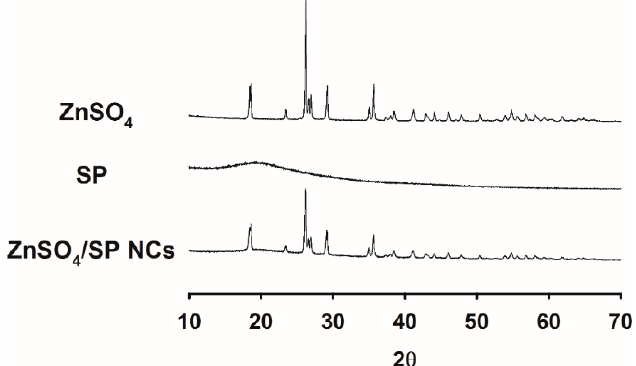
Figure 3. XRD profiles of ZnSO 4 , SP, and ZnSO 4 /SP NCs. Counts values according to 2 θ are plotted.